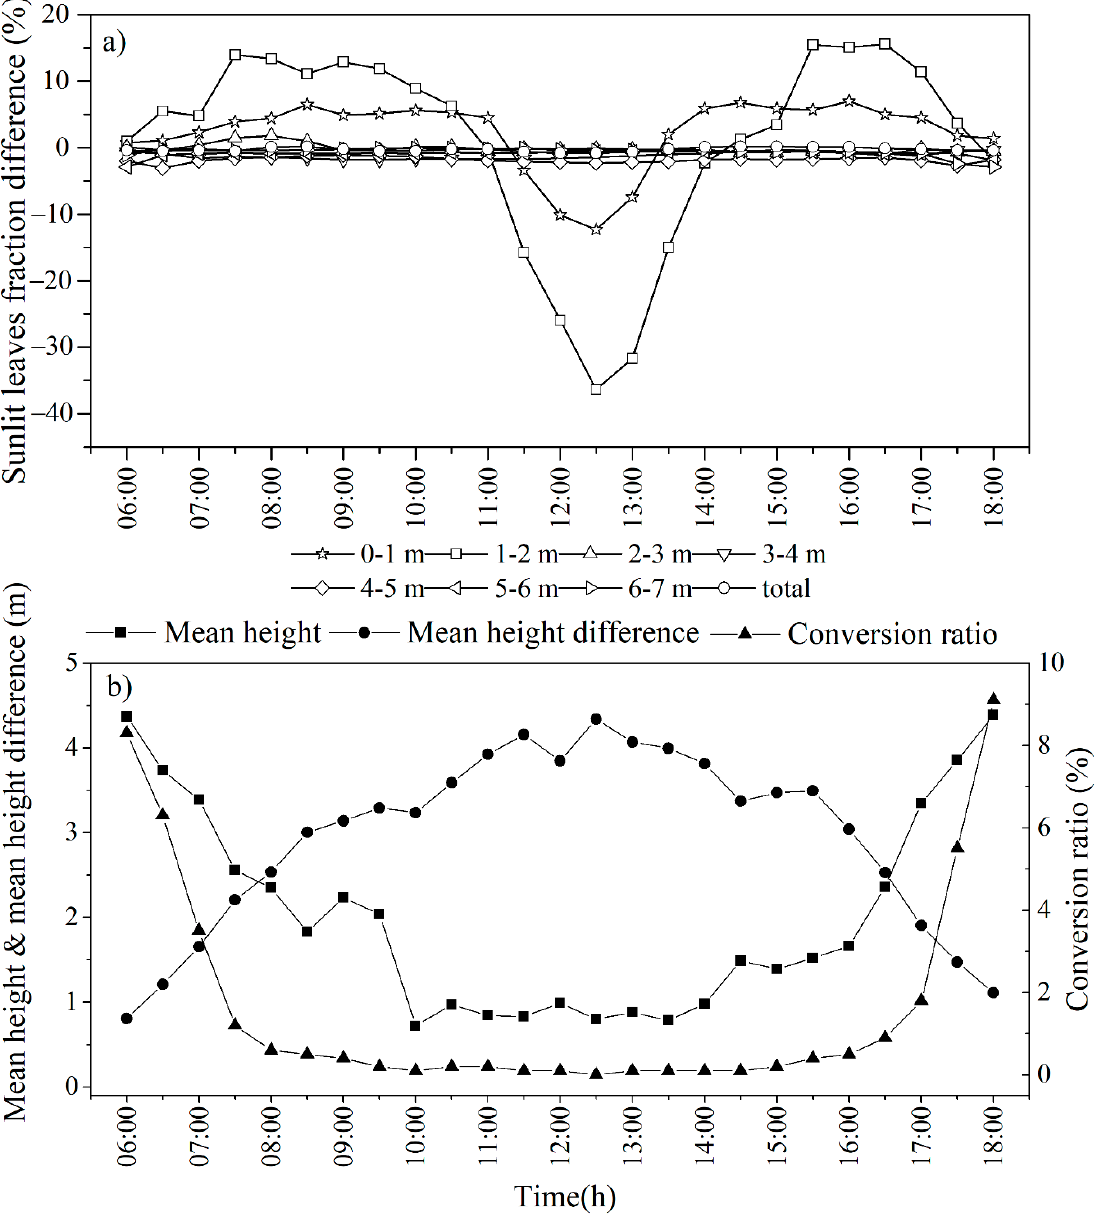
Figure 11. The temporal variations of sunlit leaf fraction differences based on the “whole forest” and “leaf-only” datasets at different horizontal layers (inset a ) and mean height, mean height differences, and conversion ratio of penumbra sunlit leaf fractions (inset b ) during a daily sun course.